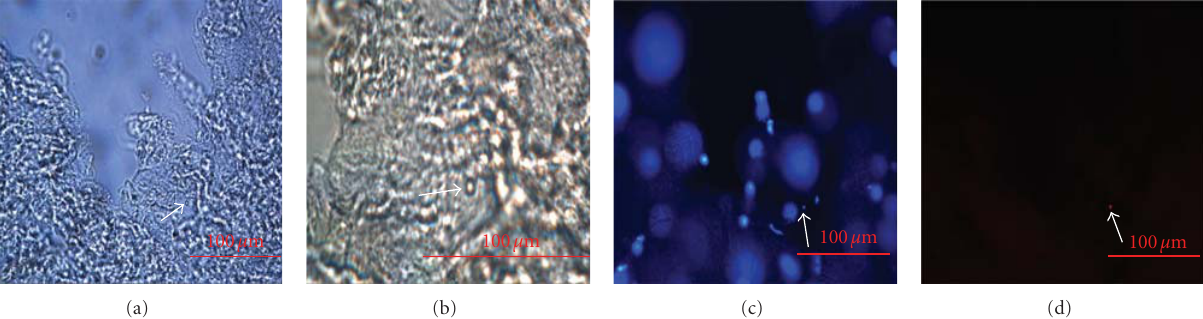
Figure 5: Small round cells (arrows)-putative stem cells in a population of cells scraped from the ovarian surface epithelium. (a) Just after scraping (magnification 400-times). (b) Just after scraping (magnification 1,000-times). (c) After DAPI staining (magnification 400-times). (d) Positively (red) stained on the SOX-2 marker of pluripotency (magnification 400-times). (Light and fluorescent microscope.)